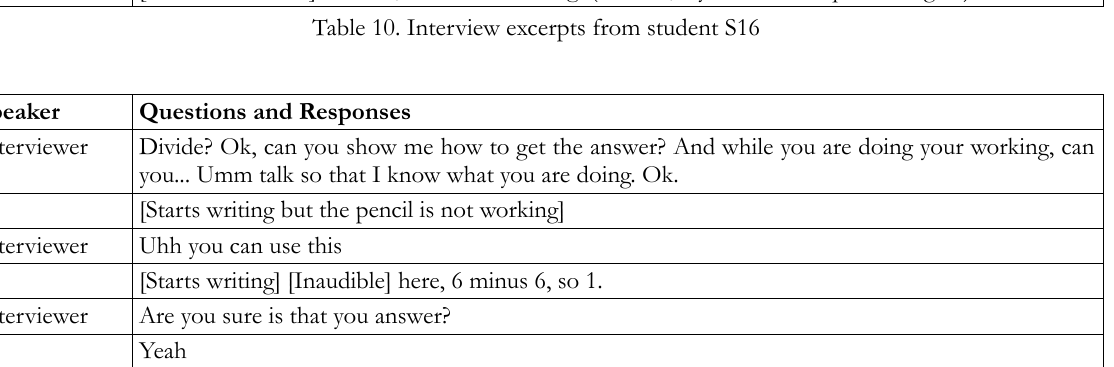
Table 11. Interview excerpts from student